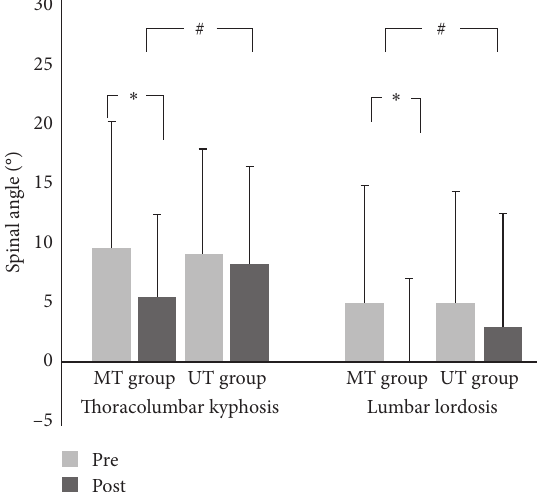
Figure 5: Change of spinal angle after training. ∗ Significant dif- ference between pre and post ( p < 0 . 05). # Significant difference between MT and UT group ( p < 0 . 05). Table 2: Correlation between pain, disability, and sitting posture. Pearson correlation coefficient